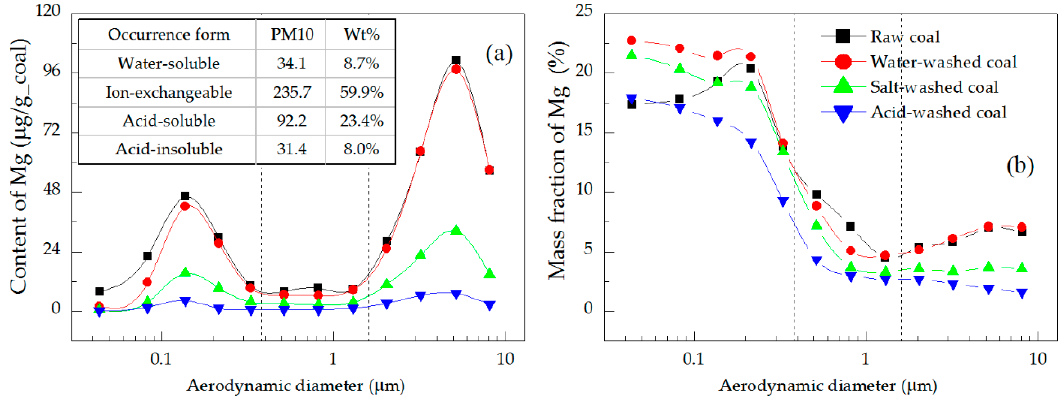
Figure 6. Distributions of the ( a ) content and ( b ) mass fraction of Mg in the PM.